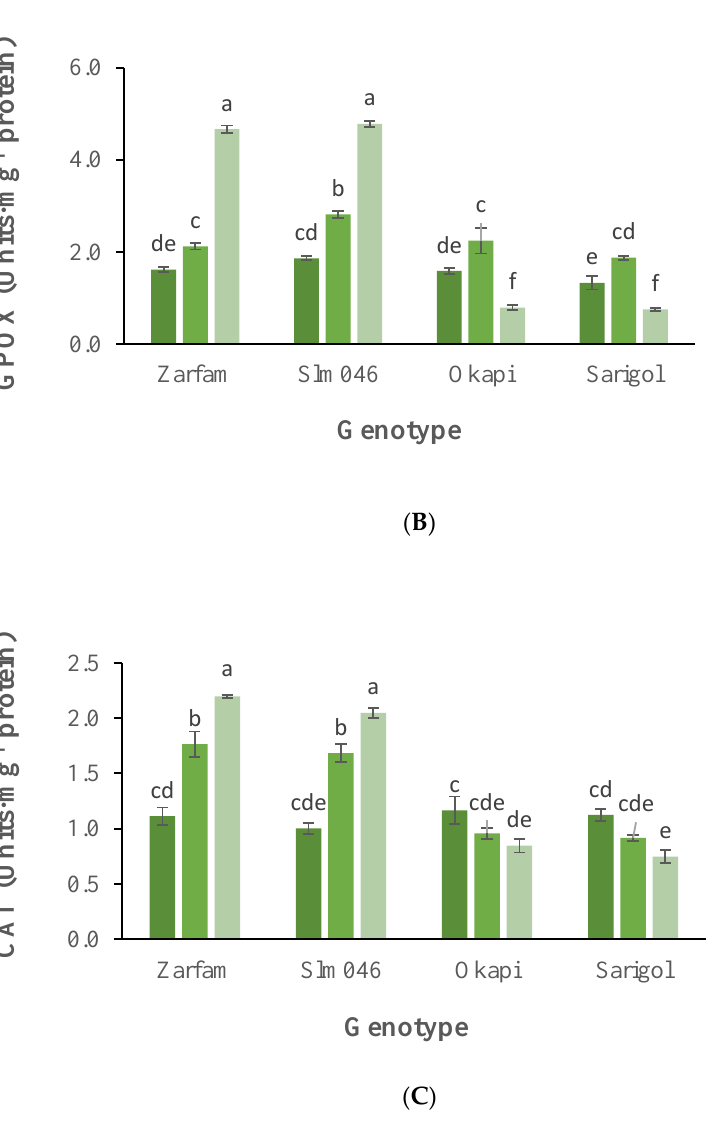
Figure 6. Interaction effect of drought stress and genotype on SOD ( A ), GPOX ( B ) and CAT ( C ) enzymatic activities in canola leaves. Data are means ( n = 3) ± SE. Different letters indicate differences ( p < 0.05) among treatments according to the Duncan